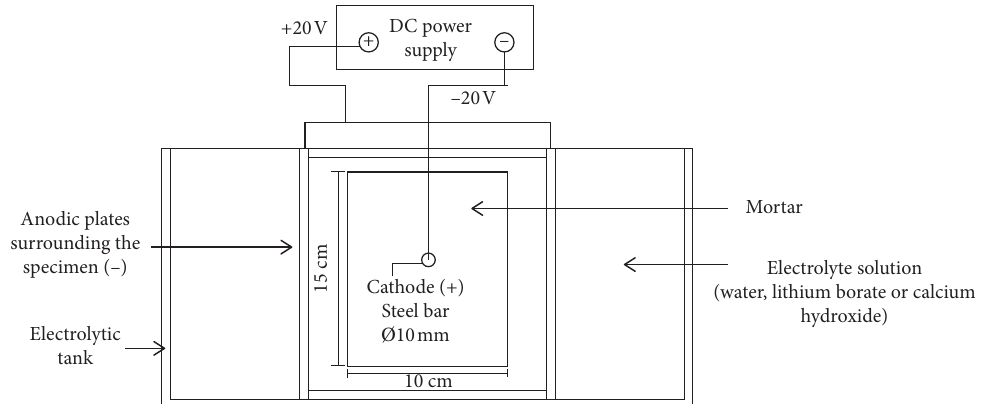
Figure 2: Schematic representation of the experimental setup for ECE using different electrolytes in aerial perspective. Each electrolytic tank contained 3 replications of each sample for better confidence of results.